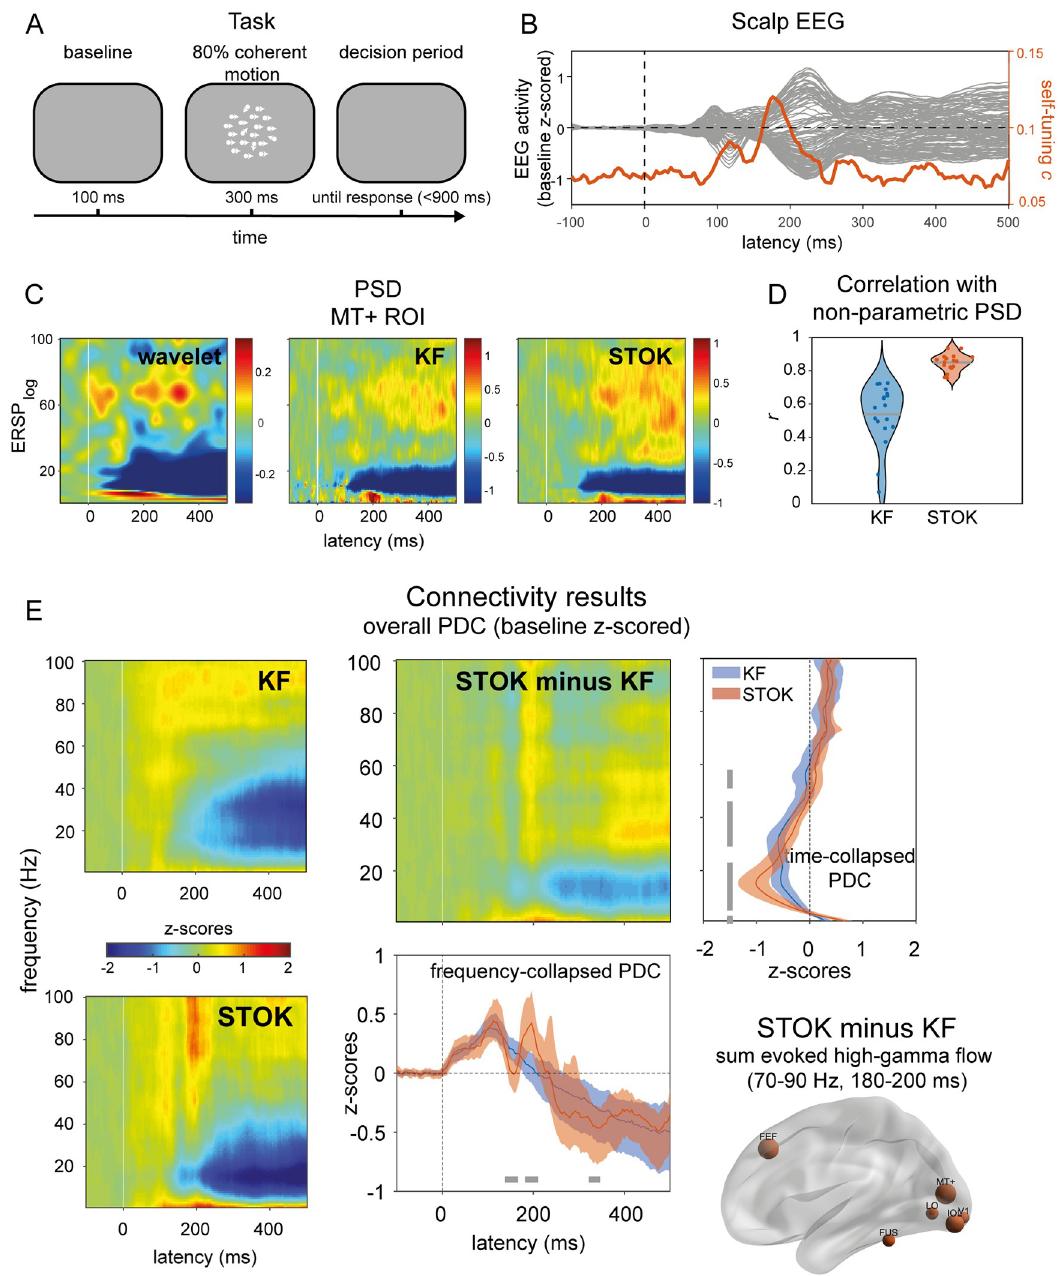
Fig 4. Results in real human evoked potentials during visual motion discrimination. (A) The visual motion discrimination paradigm presented during EEG recordings. Participants (n = 19) reported the presence of coherent motion in a briefly presented dot kinematogram (300 ms). (B) Shows grand-average event-related responses recorded at the scalp, with typical early (~100 ms) and late (~200 ms) components of visual processing. The orange line indicates the temporal dynamics detected by the self-tuning memory parameter c , that increases in anticipation of evident changes in the scalp signals. (C-D) Comparison of the non-parametric (wavelet) and parametric power spectrum densities (PSD) obtained with KF and STOK for one representative regions (MT+), with the violin plot showing the overall higher (and less variable) correlation between wavelet and STOK PSDs. (E) Global connectivity results from KF and STOK. Time-frequency plots show the results obtained with the two filters and their difference (STOK minus KF), graphically showing more evident dynamics obtained using the STOK filter. Line plots collapsing frequency and time highlight the statistical difference between STOK and KF results: STOK recovered multiple dynamic changes in overall connectivity patterns at physiologically plausible latencies (bottom plot) and characterized network desynchronization in the alpha range with higher precision (right-side plot). At frequencies (70–90 Hz) and latencies (180–200 ms) of interest for motion discrimination, the STOK revealed increased contribution to network activity (e.g., increased outflow) from visual regions, including MT+, and the frontal eye field (FEF; right-bottom plot).